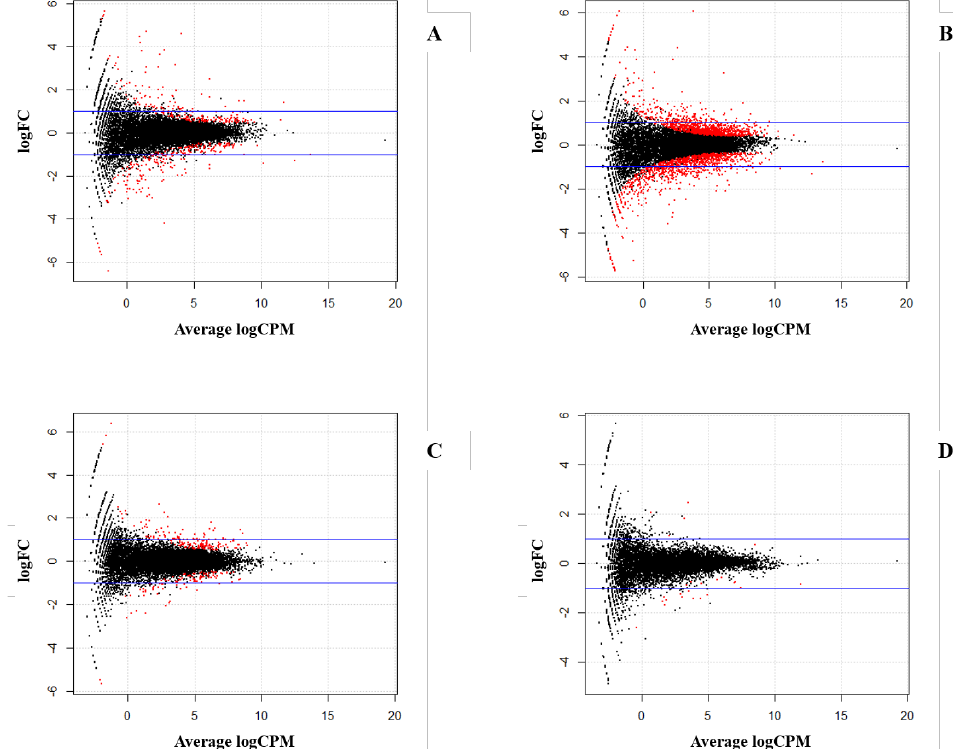
Figure 4. The di ff erentially expressed genes. ( A ) Infected birds in contrast to non-infected birds in intercross 6 3 × 7 2 . ( B ) Infected birds in contrast to non-infected birds in intercross 7 2 × 6 3 . Comparison of two reciprocal crosses in ( C ) infected groups and ( D ) non-infected groups. MA plot shows the significant di ff erentially expressed genes in red (y-axis depicts the log 2 fold change (FC) of gene expression; x-axis represents the average log reads count per million (CPM) for each gene; the blue lines denote | log 2 Fold Change | =